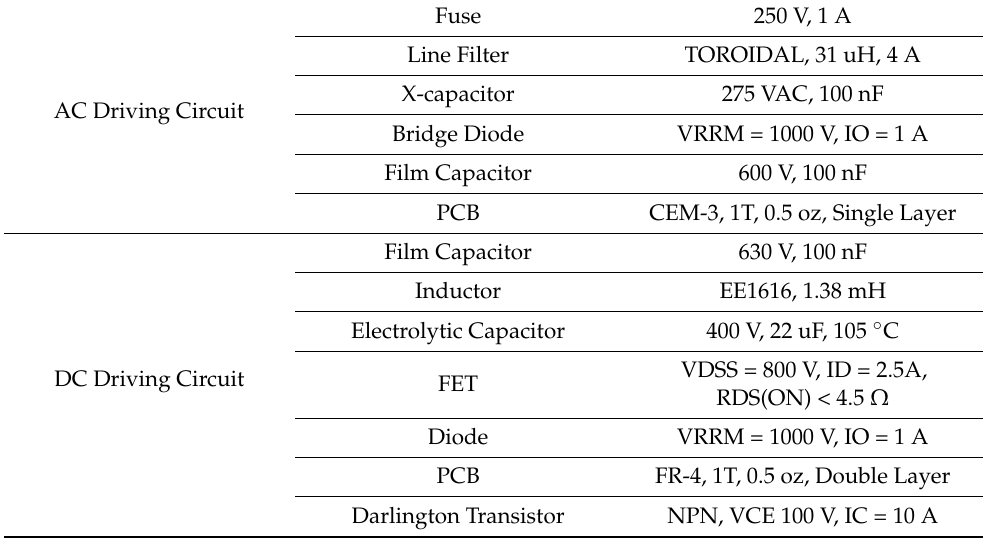
Figure 5. ( a ) AC driving circuit, ( b ) DC driving circuit, ( c ) LED module with the output ripple eliminator. Table 2. Specifications of key Table 2. Specifications of key components.